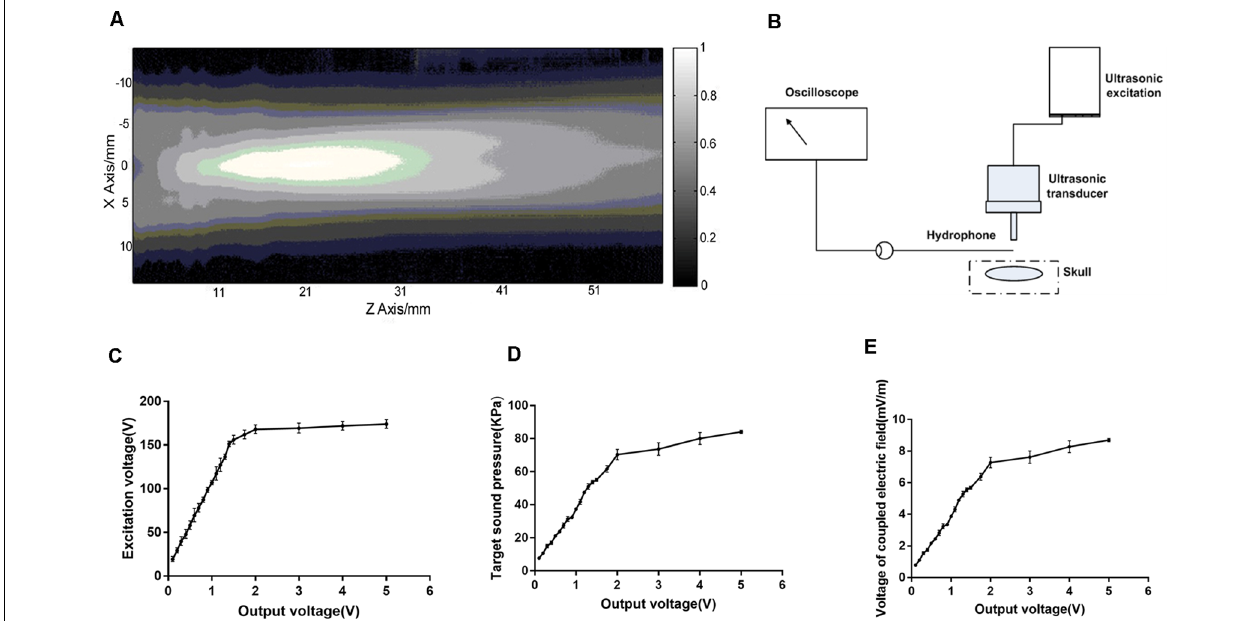
FIGURE 4 | The sound field distribution and sound pressure detection at the target. (A) The sound field distribution of the ultrasonic transducer. (B) Sound pressure detecting device. (C,D) The relationship between the output voltage of the signal generator (500 kHz, 300 pulses, 1 kHz PRF, 400 NTB, T = 4 s) and sound pressure of the ultrasound transducer at the target. (E) Electric field generated by magneto-acoustic coupling.